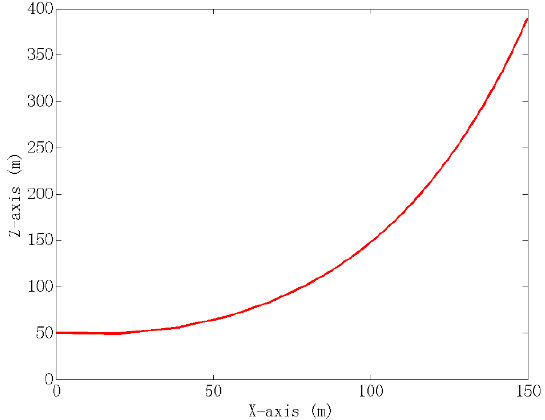
Figure 2. Configuration of the single mooring line.